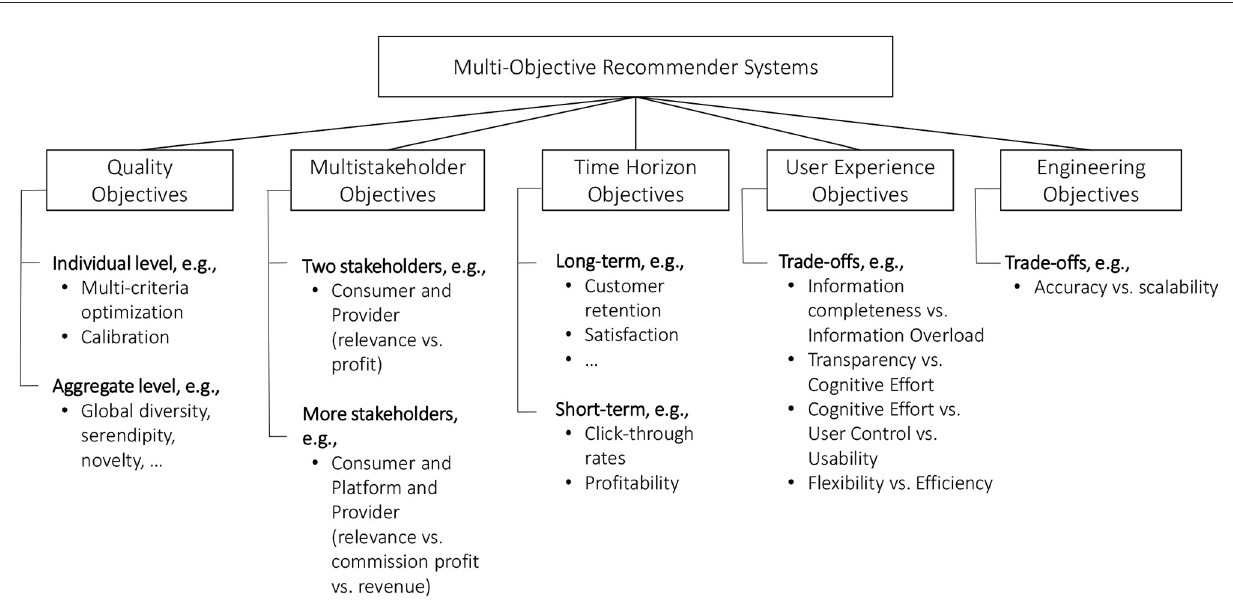
FIGURE1 Taxonomy of different types of multi-objective recommendation